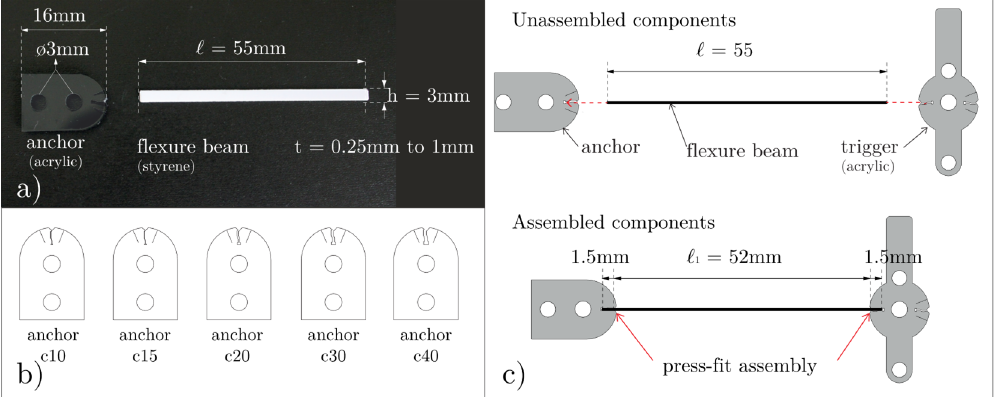
Figure 4. ( a ) Picture of actual components. The anchor is made of acrylic and the flexure beam of styrene plastic. ( b ) Schematics of anchor components. The width of their slots gets larger according to the caliber of the flexure beam. ( c ) The flexure beams are press-fit assembled to the anchor and trigger.